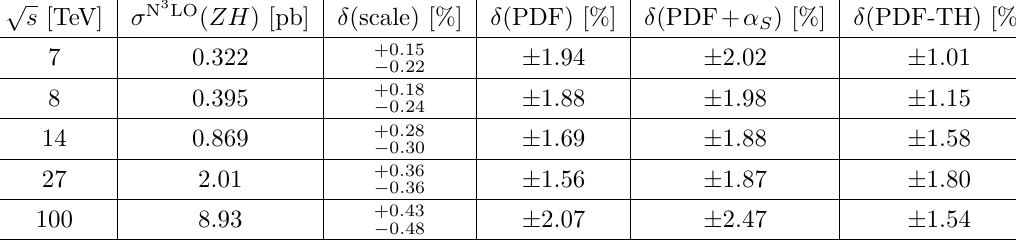
Table 9 . The same as in table 7, but for the ZH process and with µ 0 = M HZ